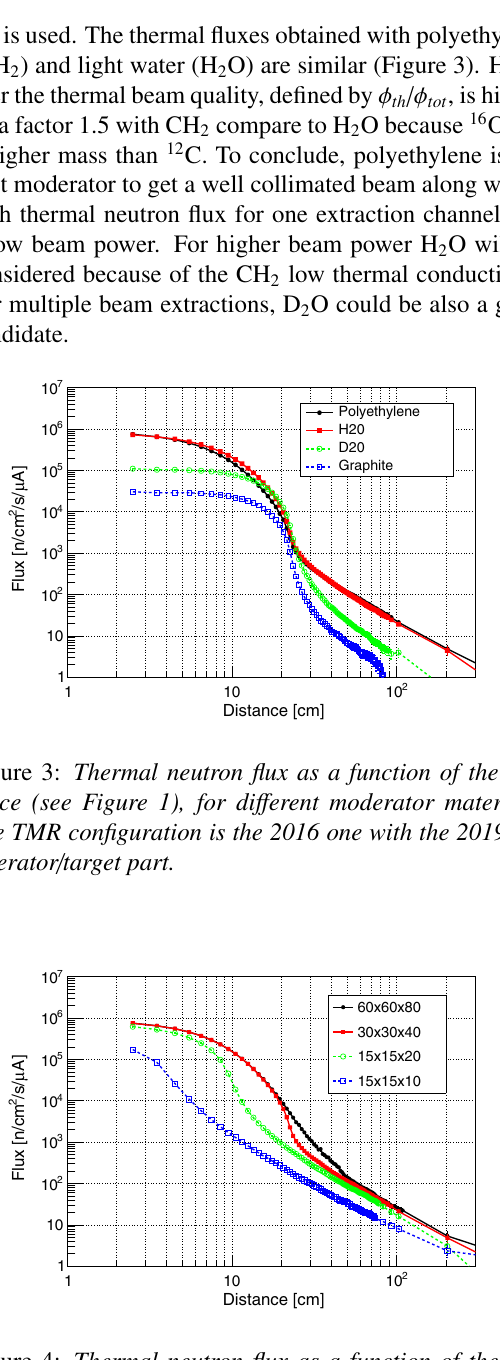
Figure 4: Thermal neutron flux as a function of the dis- tance (see Figure 1), for di ff erent polyethylene moderator